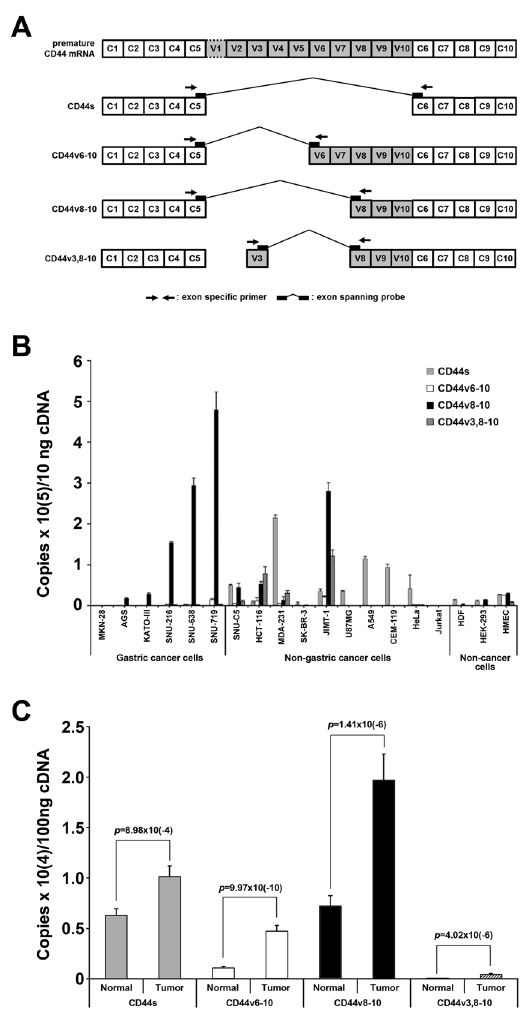
Figure 1. ( A ) Structure of human CD44 pre-mRNA and its alternative splice variants. To detect alternative splice variants, CD44s or CD44v specific TaqMan probes spanning the border of contiguous exons and primer pairs were applied. ( B ) The comparison of mRNA expression levels of CD44s and CD44v in the cell lines measured by absolute quantification of qRT-PCR. ( C ) The comparison of mRNA expression level of CD44s and CD44v between normal and tumour tissue of stomach cancer patients ( n =